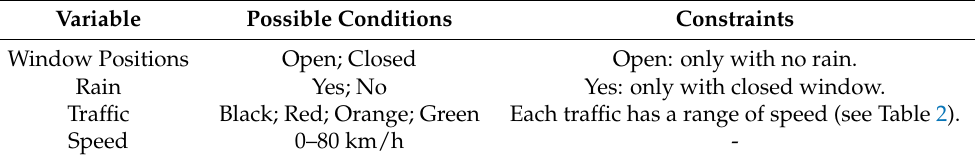
Table 1. Conditions of the controlled environment variables.